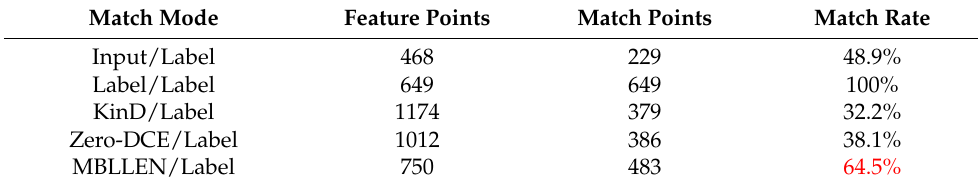
Table 7. Comparison of image matching results enhanced by different